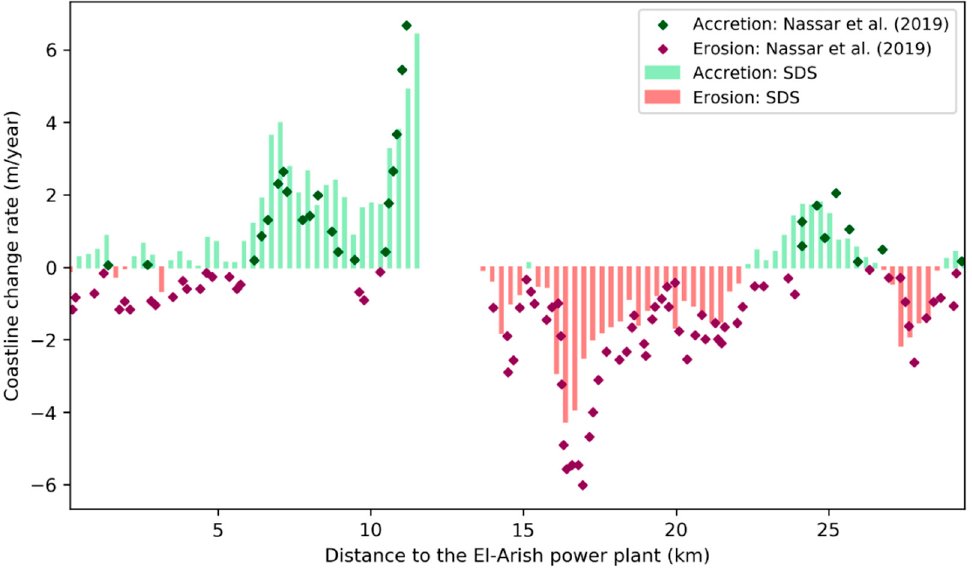
Figure 16. Spatial accretion (in green) and erosion (in red) patterns expressed in coastline change rates (m/year) for shore-normal transects down-drift of El-Arish power plant between 1989 and 2016. The results of Nassar et al. [47] are represented by dots and our results by bars.